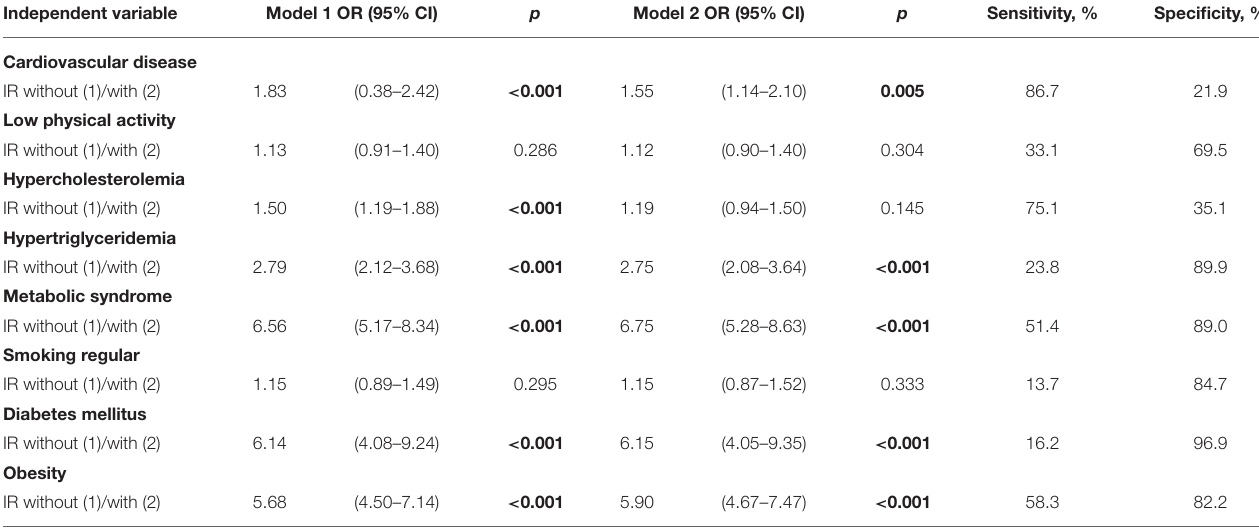
TABLE 4 | Logistic regression between insulin resistance and cardiovascular risk factors. Independent